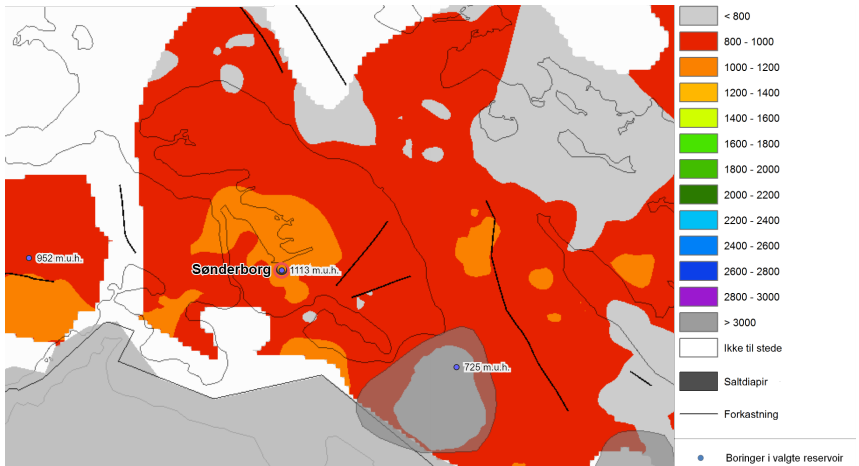
Figure 1. Depth-to-top of the Gassum Formation in the Sønderborg area (meters). Locations of salt pillows (saltpude) are also included